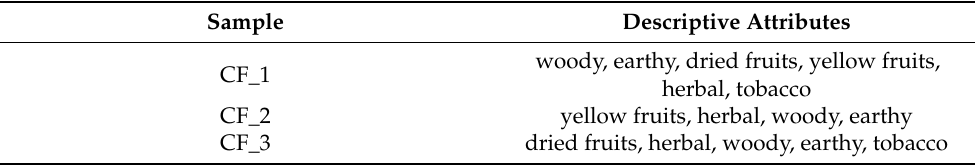
Table 9. Descriptive attributes of coffee